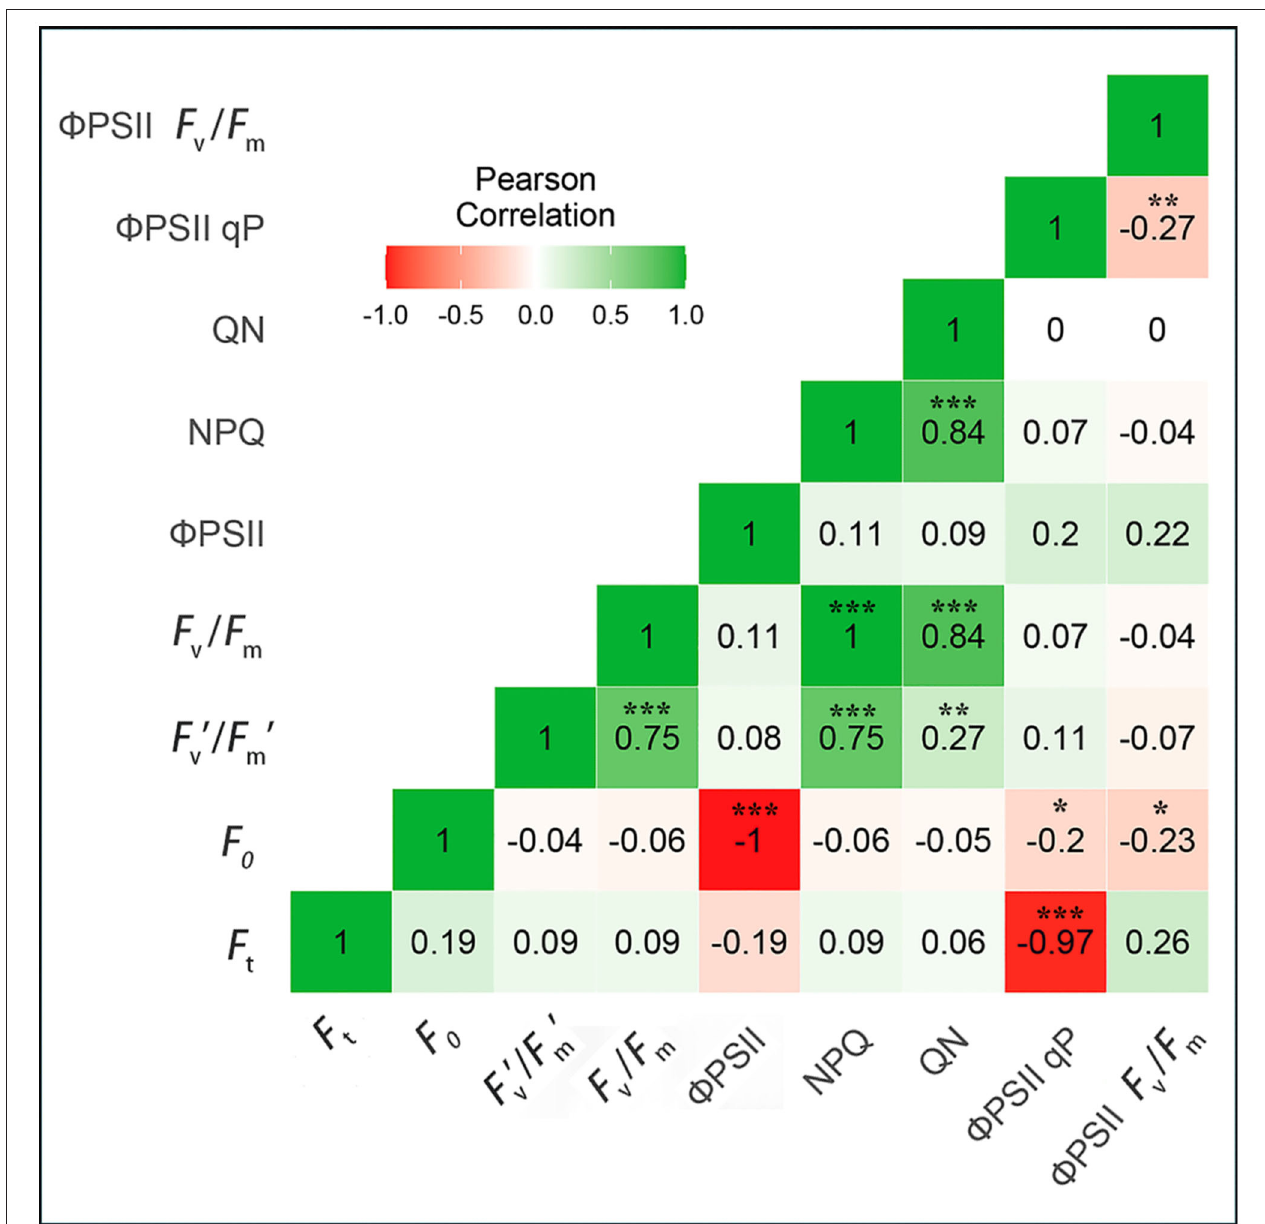
FIGURE 9 | Correlation matrix of chlorophyll fluorescence parameters in young-mature leaves of invasive and native plant species, the labels were similar in Table 1 . The colored gradient legends represent coefficients of correlation r values from + 1.0 (green) to − 1.0 (red). The significant correlation at a level ( p *** < 0.001), ( p ** < 0.001), ( P * < 0.05). All coefficients were computed by the Pearson correlation for possible pairs of variables in the